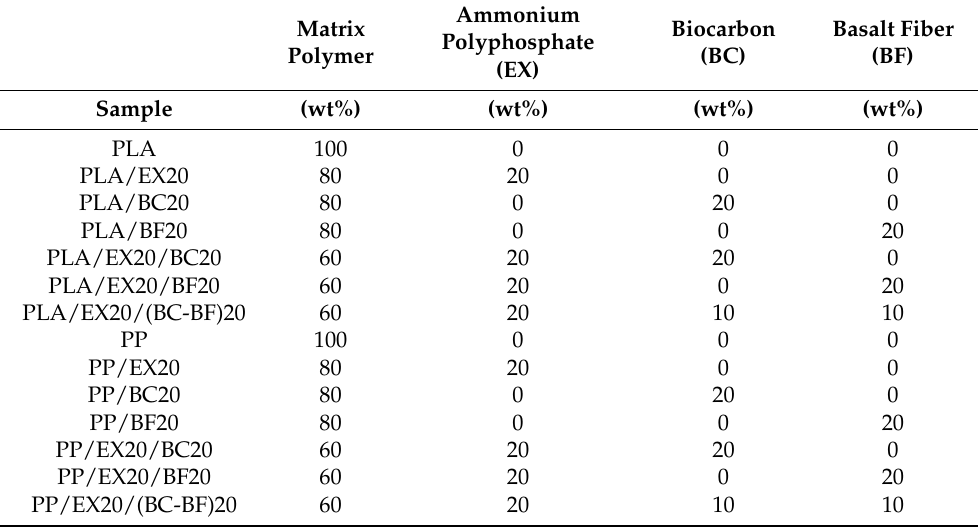
Table 2. The list of sample designation and composite